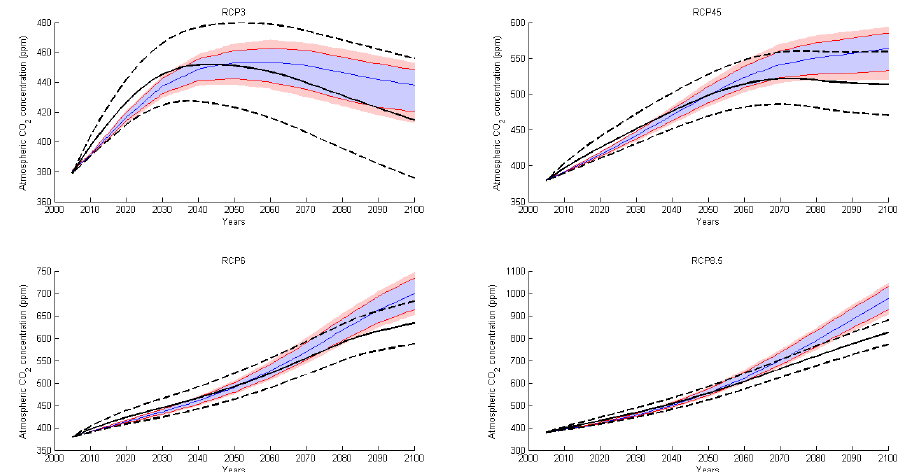
Figure A4. TIAM-World climate module: Uncertainty in the global mean temperature against MAGICC6 ranges for the four RCP scenarios.